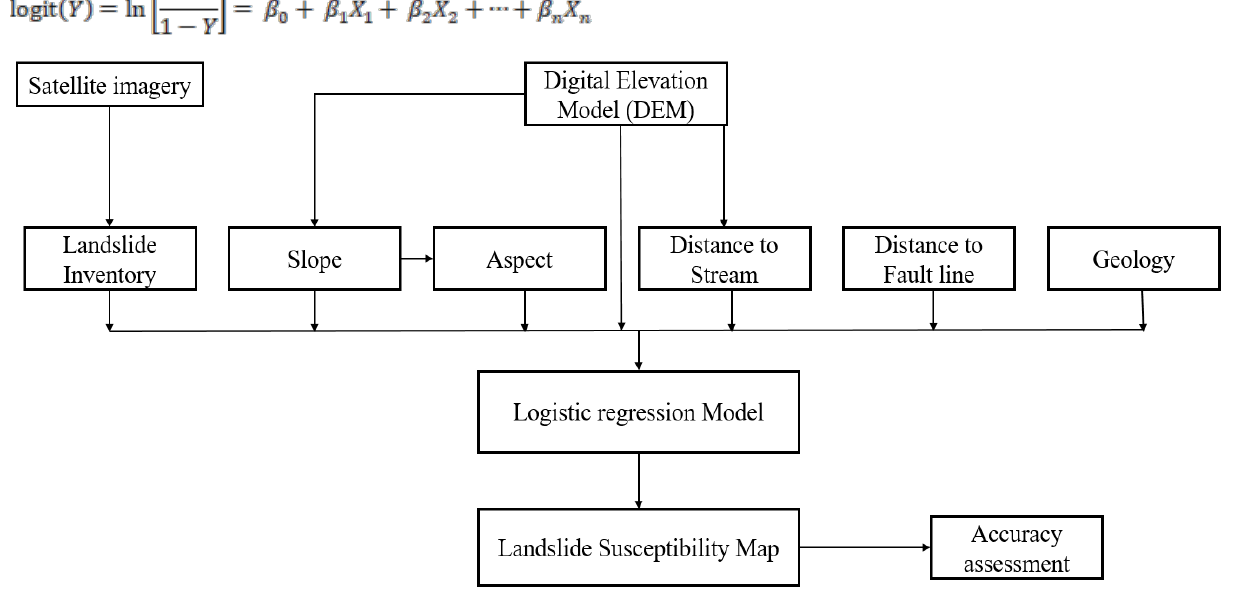
Figure 2: Methodology Flowchart of research